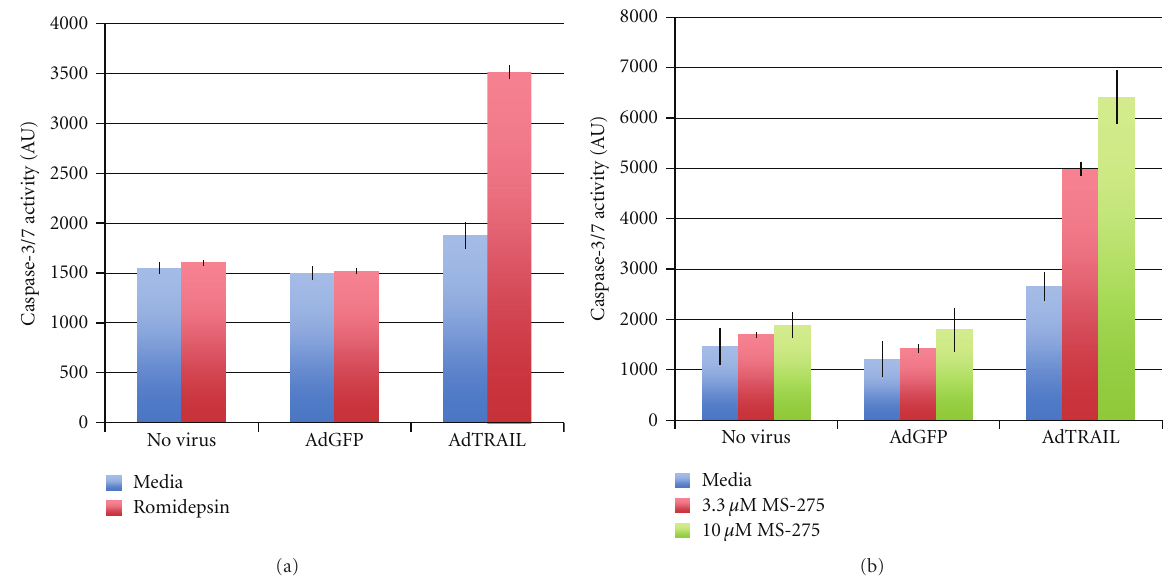
Figure 5: Caspase-3/7 activity in C4-2b cells. C4-2b cells were left uninfected or were transduced with 10 MOI of AdGFP or AdTRAIL in the absence or presence of MS-275 (b) or 10 ng/mL romidepsin (a). Caspase-3/7 activity was determined at 48 hours. Data shown are the mean ± SD of an assay performed in